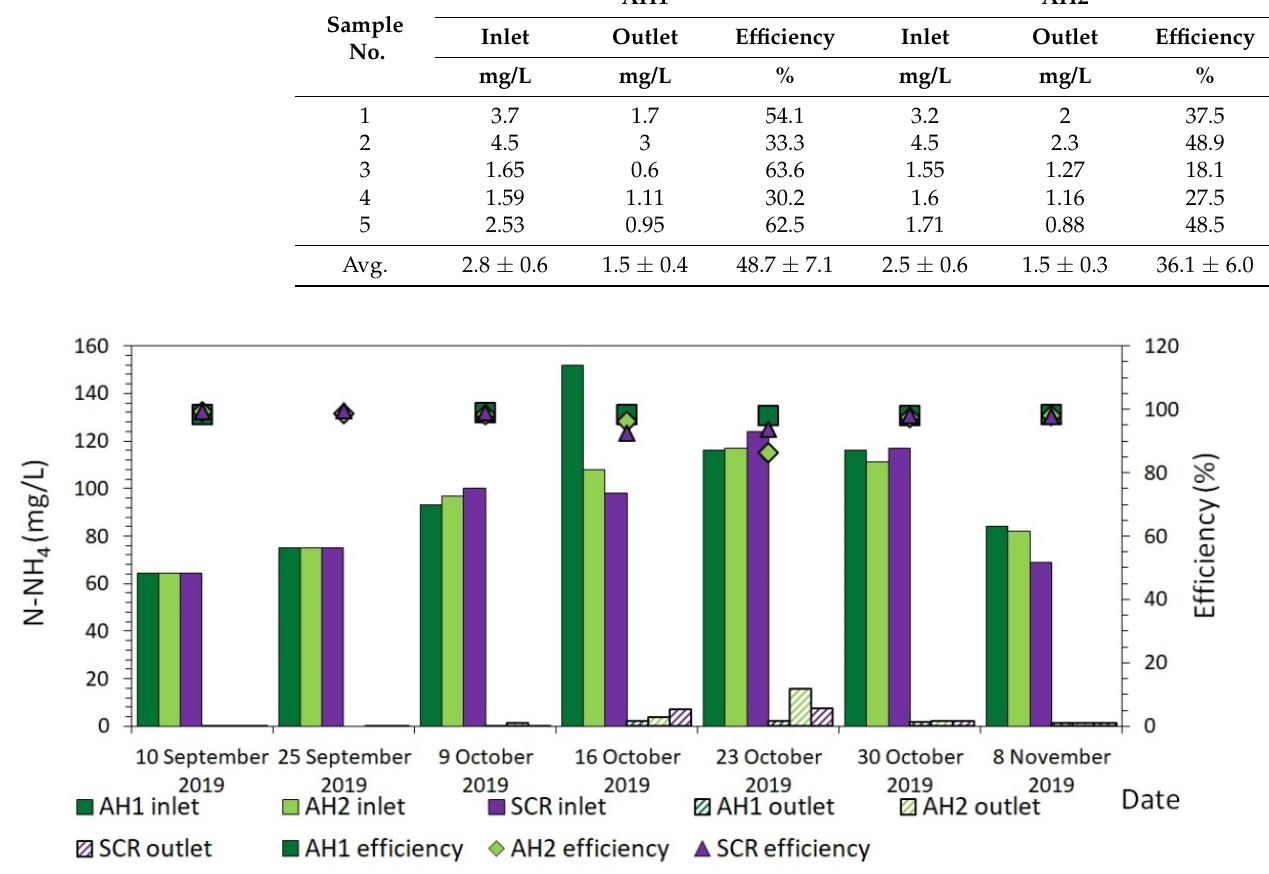
Figure 8. Inlet and outlet N NH4 and removal efficiencies at stage I.